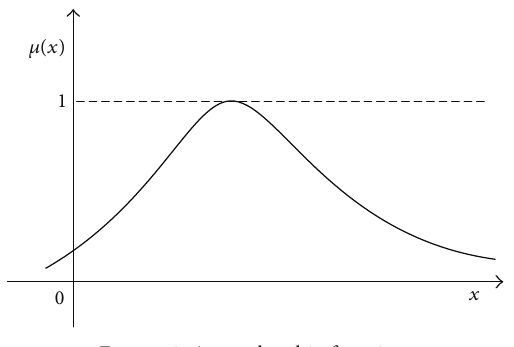
Figure 2: A membership